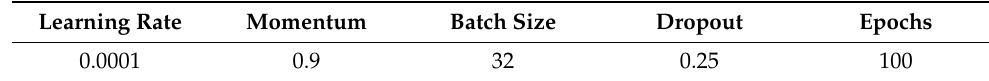
Table 1. Hyperparameters used to train the CNN. Learning